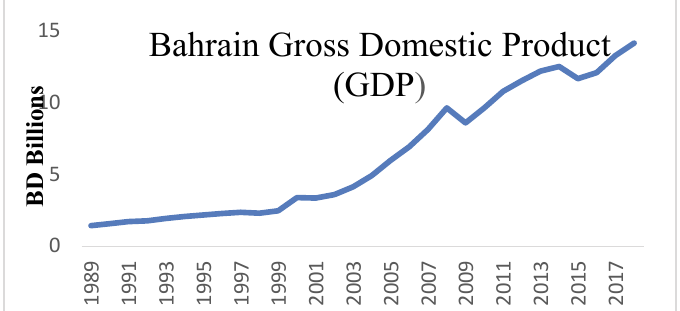
Fig. 1. Gross Domestic Product (GDP) for the 1989-2018